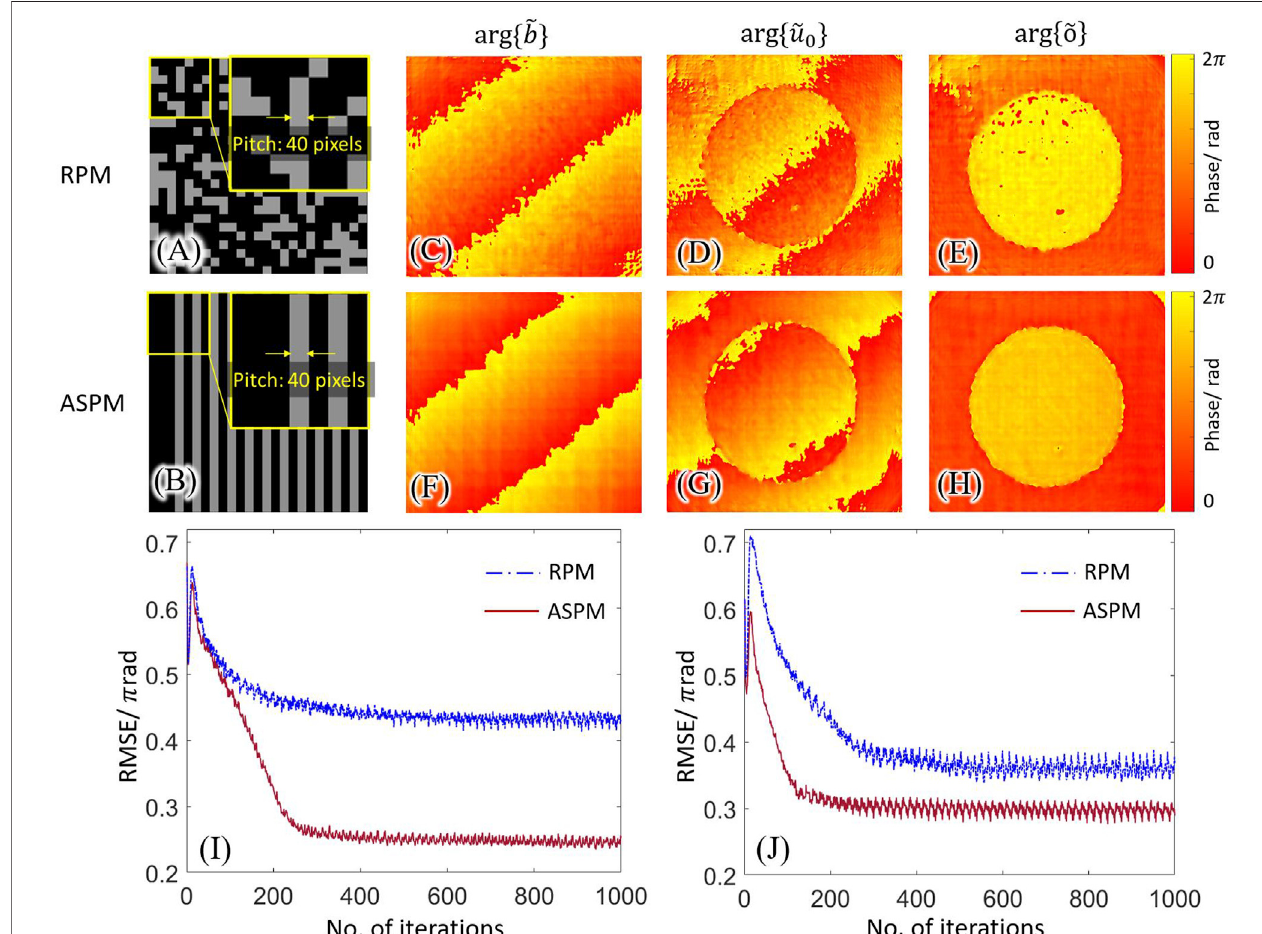
FIGURE 10 | Evaluation of the ASPM and RPM methods. (A) One of the sixteen RPM patterns. (B) One of the sixteen ASPM patterns. (C – E) Reconstructed background phase, object phase without background subtraction, and object phase with background subtraction using RPM method. (F – H) Reconstructed backgroundphase,objectphasewithoutbackgroundsubtraction,andobjectphasewithbackgroundsubtractionusingtheASPMmethod. (I) RMSEinthebackground reconstruction using the ASPM and RPM methods. (J) RMSE in the object phase reconstruction using the ASPM and RPM